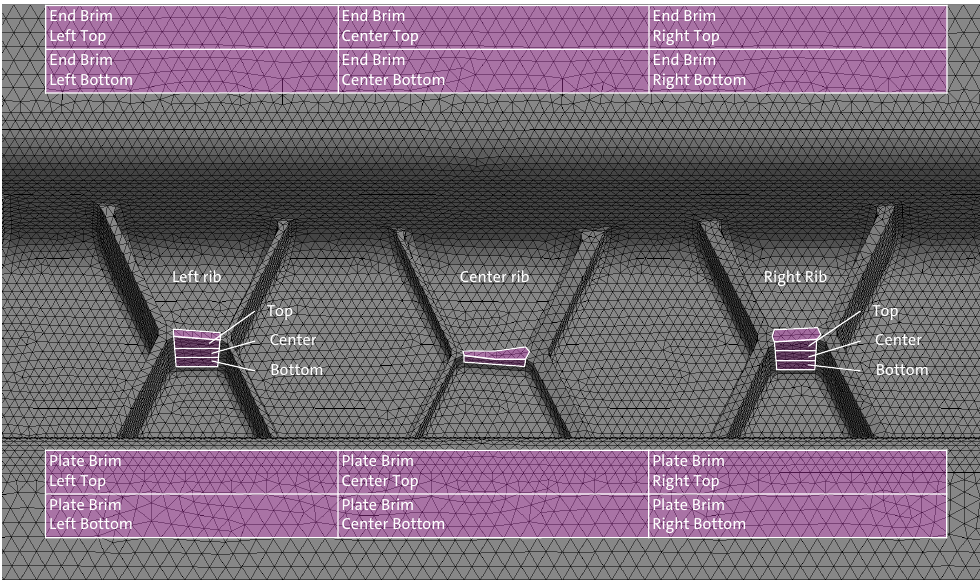
Figure 24. CAD image of the ribbed structure’s middle section (3D view, superimposed tetra mesh) with all analysis areas used for the comparison of the averaged fiber orientations of all three CT scans with the fiber orientations predicted with 3D TIMON CompositePRESS.